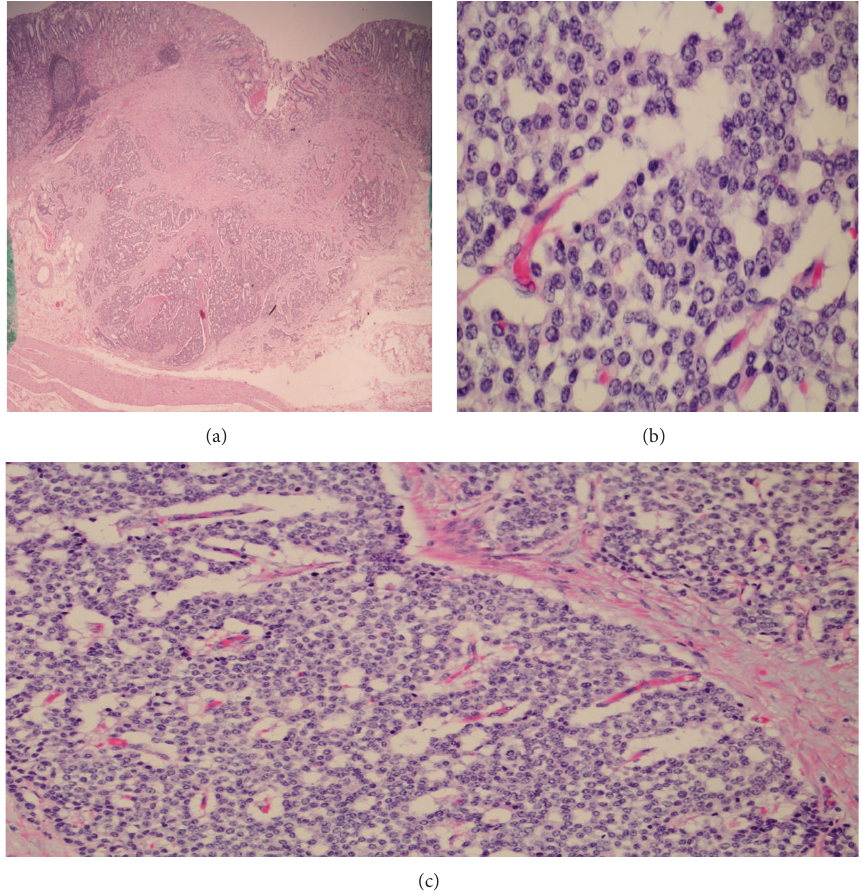
Figure 4: A well-differentiated neuroendocrine tumor consistent with a gastric